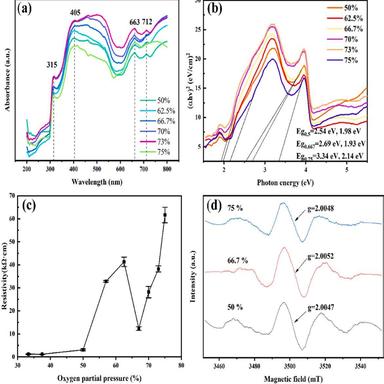
Chromium oxide films under different oxygen partial pressures: (a) Ultraviolet–visible absorption spectra, (b) Band gap diagrams calculated using the Tauc plot, (c) Resistivity versus oxygen partial pressure diagram, (d) Graph of film thickness variation with oxygen partial pressure.